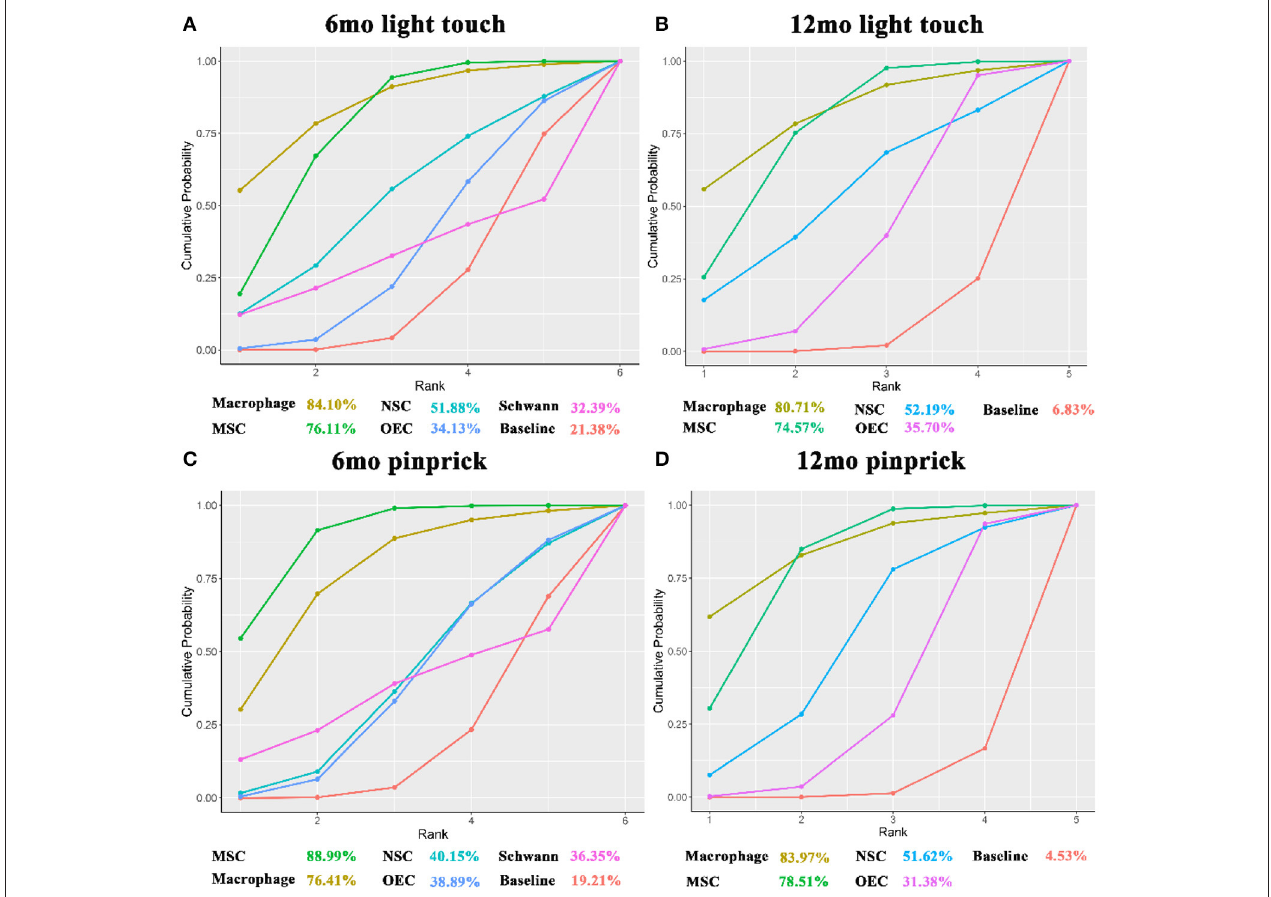
FIGURE 6 | SUCRA for ASIA light touch and pinprick. (A) SUCRA for 6mo ASIA light touch score; (B) SUCRA for 12mo ASIA light touch score; (C) SUCRA for 6mo ASIA pinprick score; (D) SUCRA for 12mo ASIA pinprick score. The x-axis represents the ranking and the y-axis represents the cumulative probability. The cumulative ranking and cumulative probability are constructed as a curve. The larger the area under the curve, the greater the benefit of the intervention. mo, month; SUCRA, the surface under the cumulative ranking; MSC, mesenchymal stem cell; NSC, neural stem cell/neural progenitor cell; OEC, olfactory ensheathing